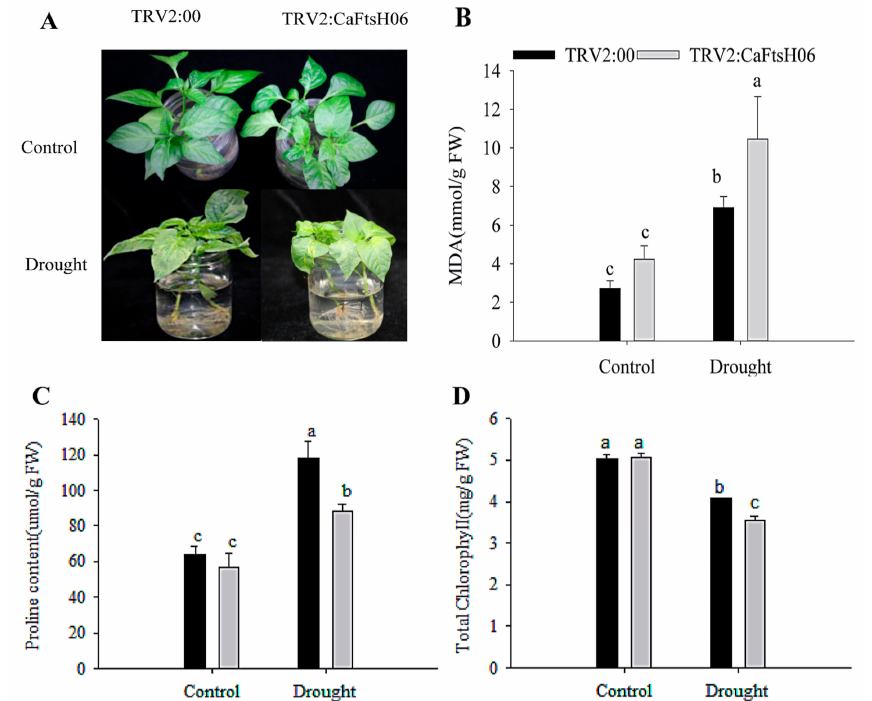
Figure 8. Analysis of osmotic tolerance of CaFtsH06 -silenced pepper. ( A ) Phenotype identification of pTRV2:00 and pTRV2: CaFtsH6 plants after osmotic stress. ( B ) The MDA content of plants after osmotic stress. ( C ) The proline content of plants after osmotic stress. ( D ) Total chlorophyll content of plants after osmotic stress. Different letters denote statistical significance ( p <